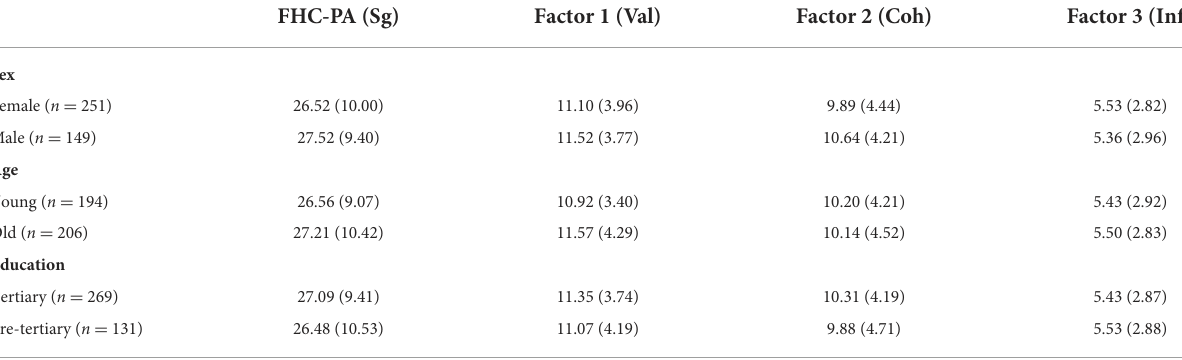
TABLE 11 Demographic group means and standard deviations for FHC-PA (Sg) scale and factor levels.